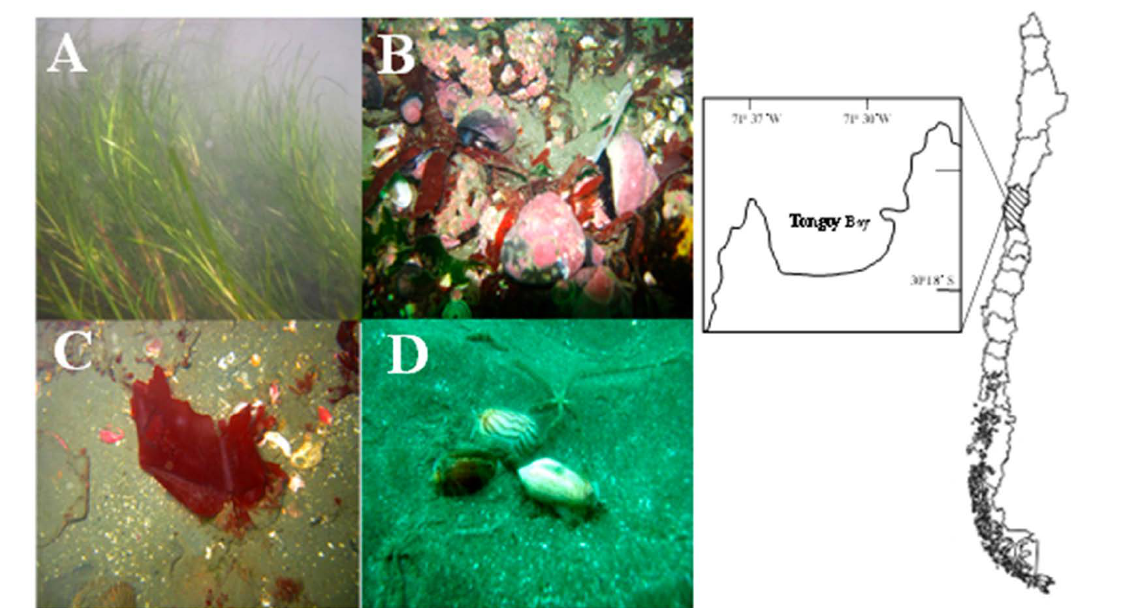
Fig.1. – Study area and habitat types with different structural complexities present in the Tongoy Bay benthic system: A, seagrass; B, sand- gravel; C, mud; and D,